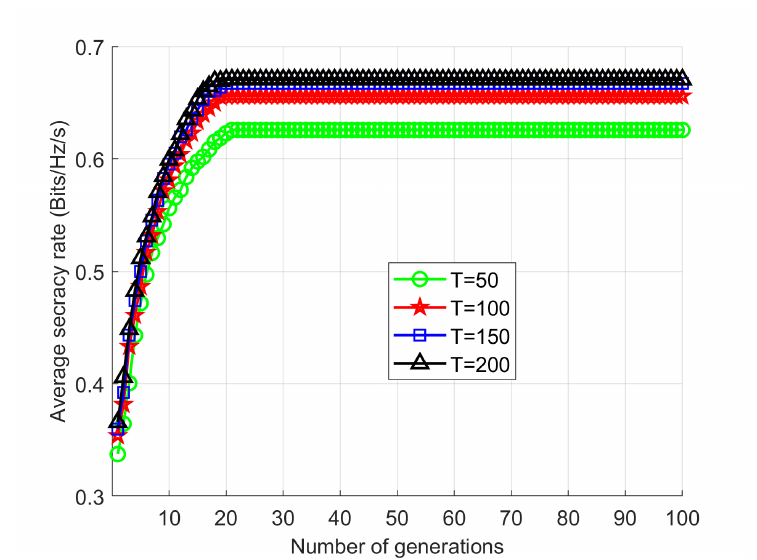
Figure 4. SR against the number of generations I g . Table 2. CPU time against total number of SU